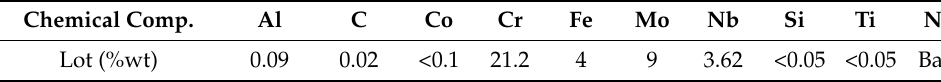
Table 1. Chemical composition of metal powder.